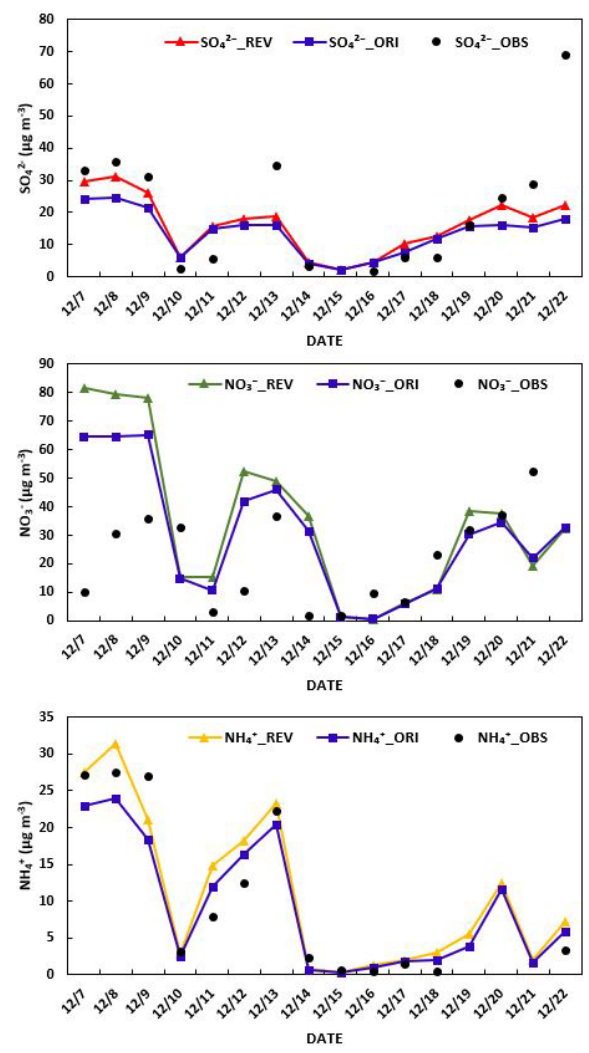
Figure 4. A comparison of simulated and observed daily averaged sulfate, nitrate, and ammonium concentration in